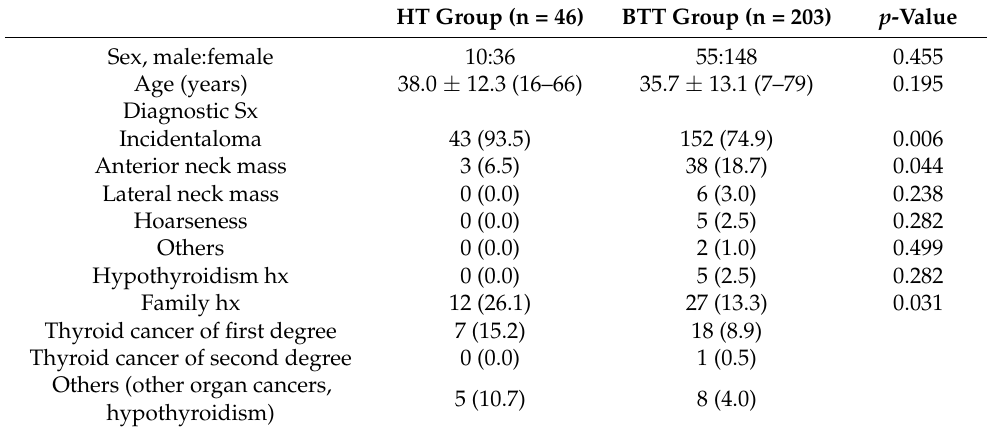
Table 1. Comparison of patient characteristics between patients who underwent HT and